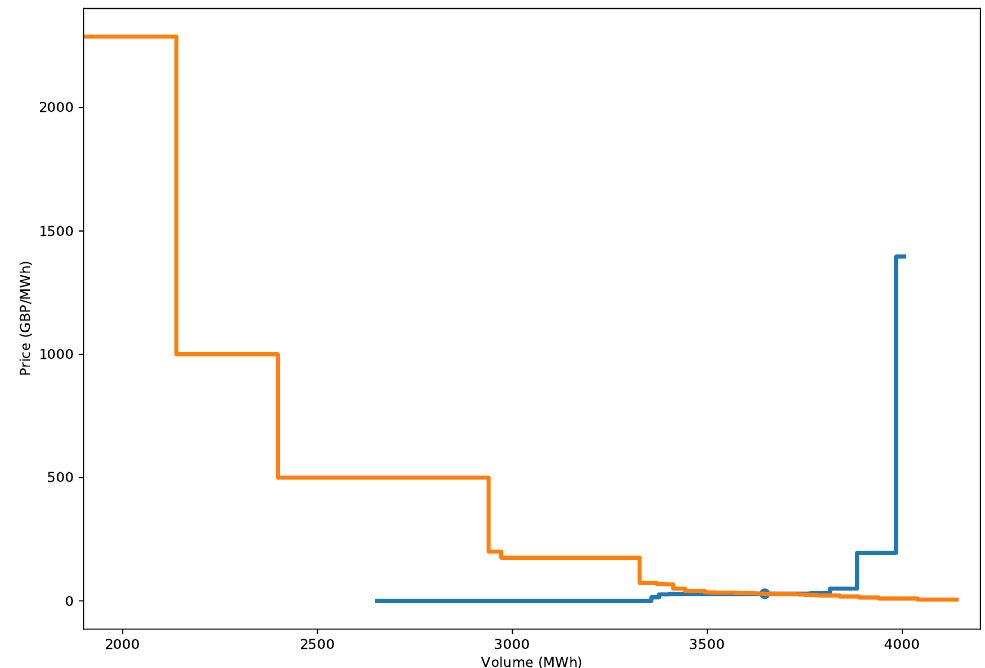
Figure 1. Example of the supply (blue) and demand (orange) curves and their intersection (blue dot) giving the wholesale clearance